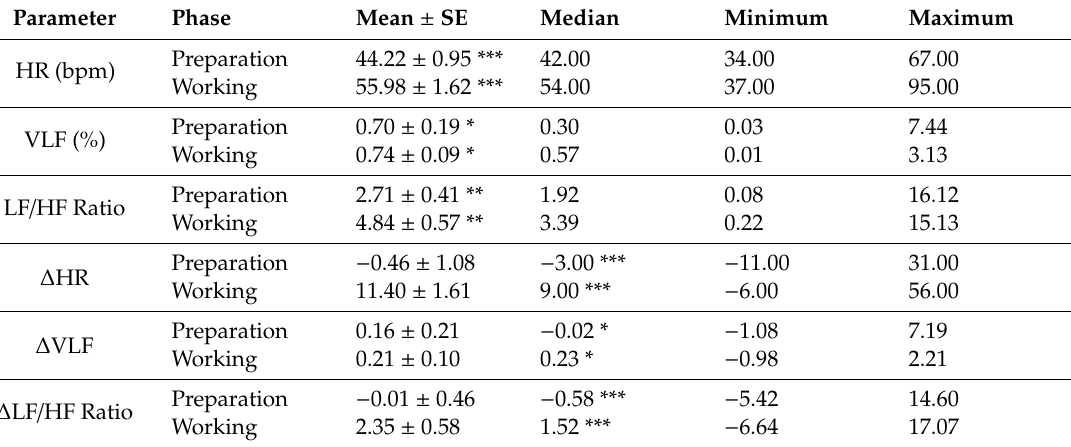
Table 4. EAT e ff ect on HRV: e ff ect of phase.